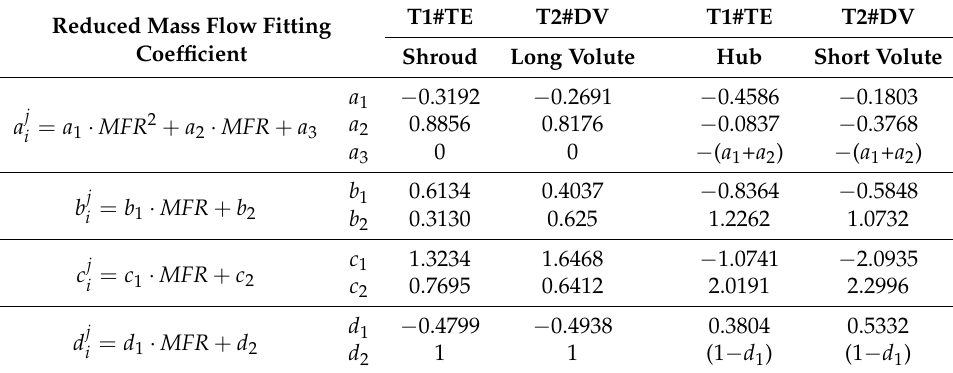
Table 2. Reduced mass flow fitting coefficient trends value for T#1TE and T#2DV turbines obtained in a global fitting procedure.